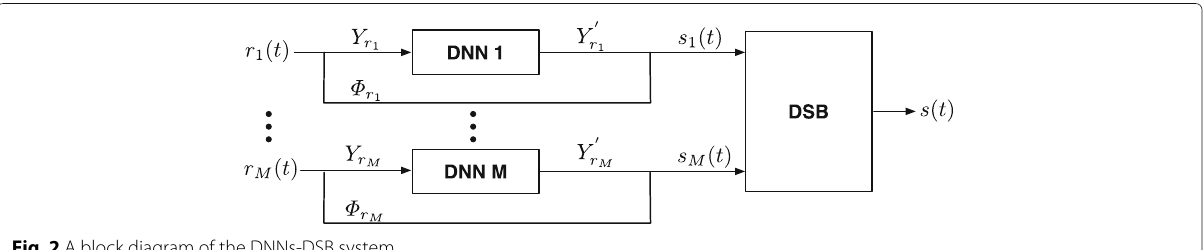
Fig. 2 A block diagram of the DNNs-DSB system